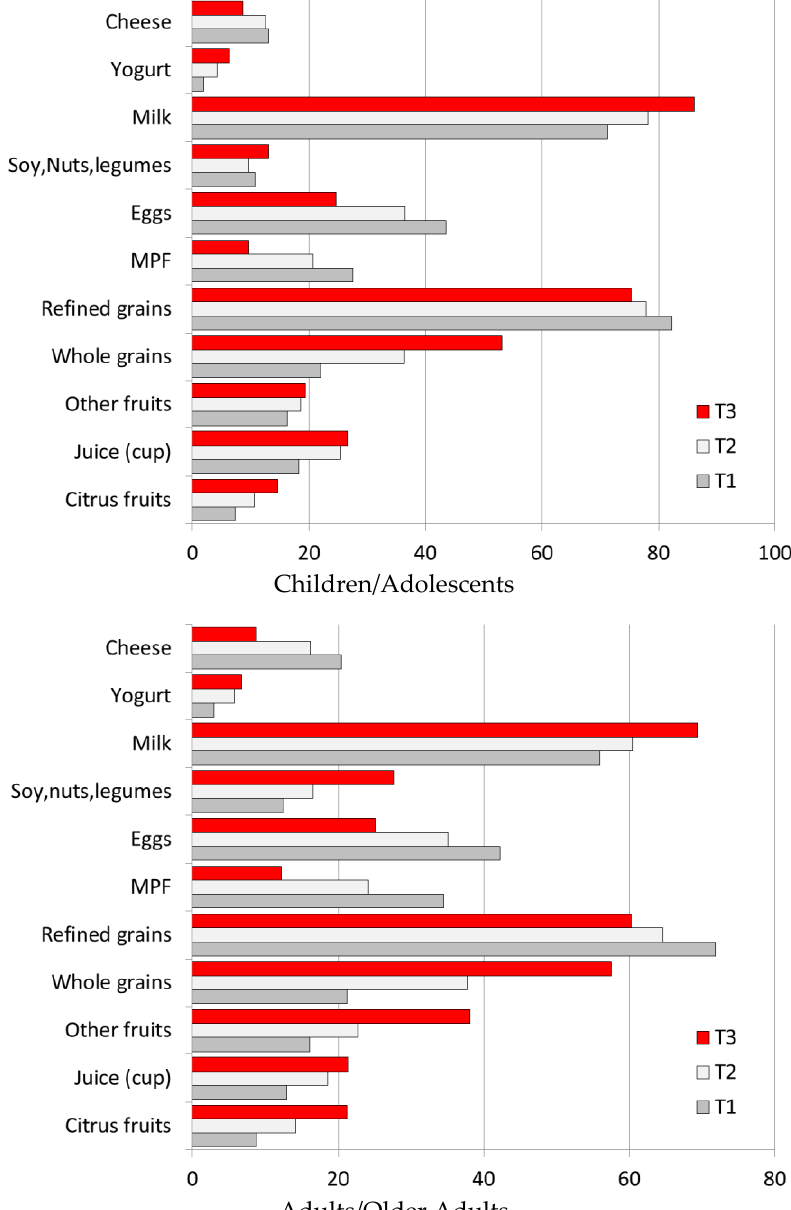
Figure 5. Percent consumers at breakfast for selected food groups by NRF9.3 tertiles. MPF stands for Meat, Poultry, Fish.